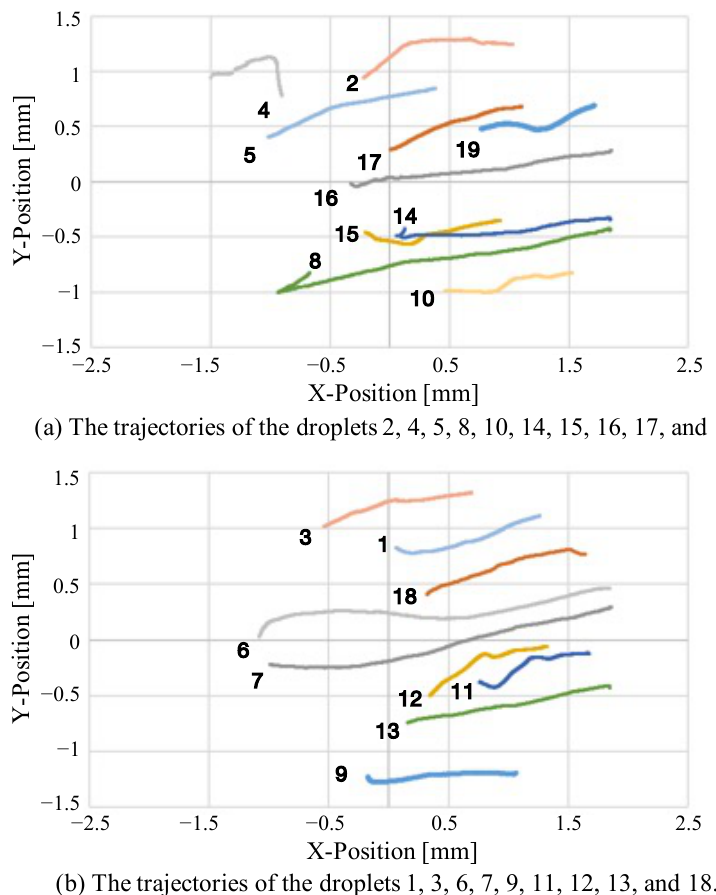
Figure 10. Changes in the position of a droplet over